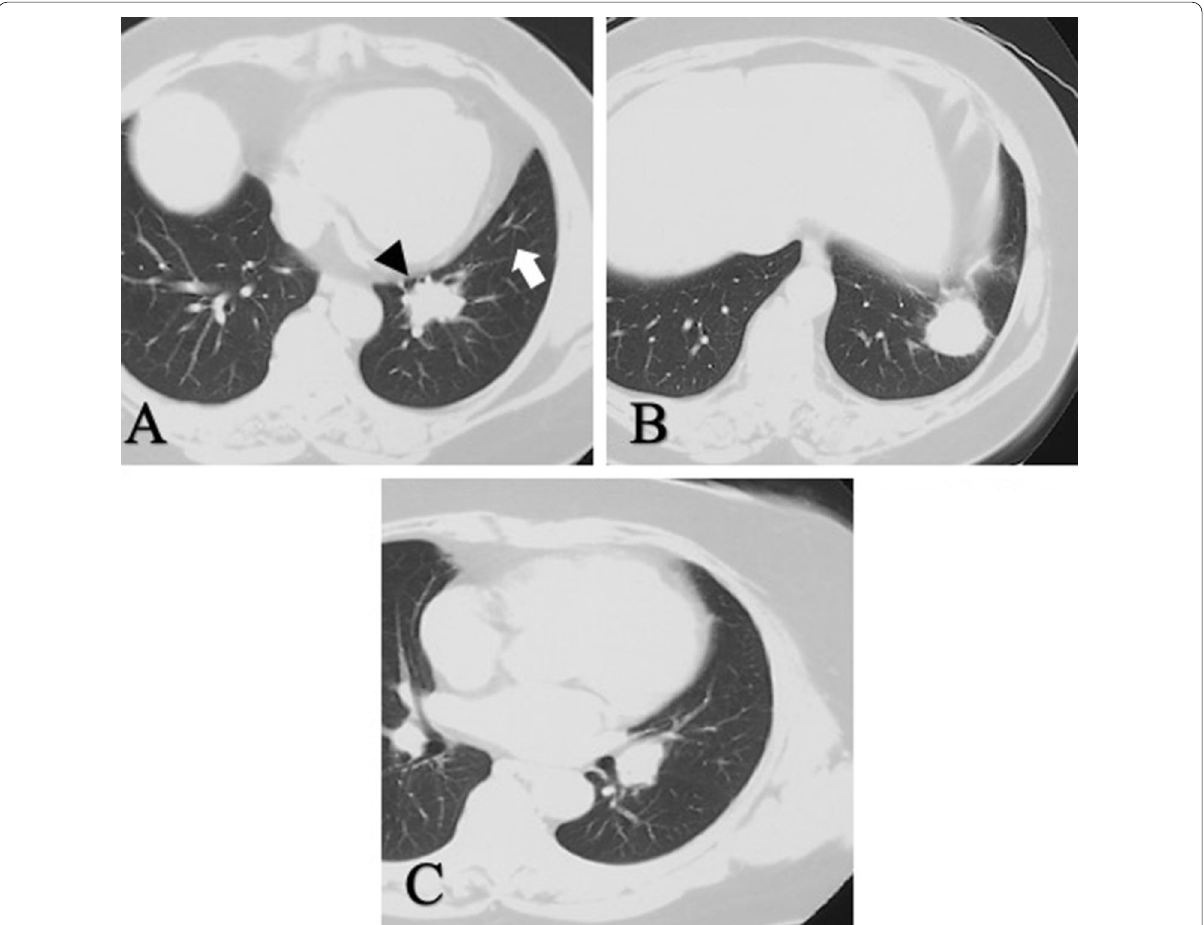
Fig. 1 Computed tomography scan results showing two pulmonary nodules and swollen interlobar node. a A 30-mm nodule in the center of the antero-basal segment of the left lower lobe. Suspicious interlobar invasion of S8 tumor (black arrowhead) and interlobar fissure (white arrow). b Another nodule in the lateral segment of the left lower lobe. c A swollen interlobar lymph